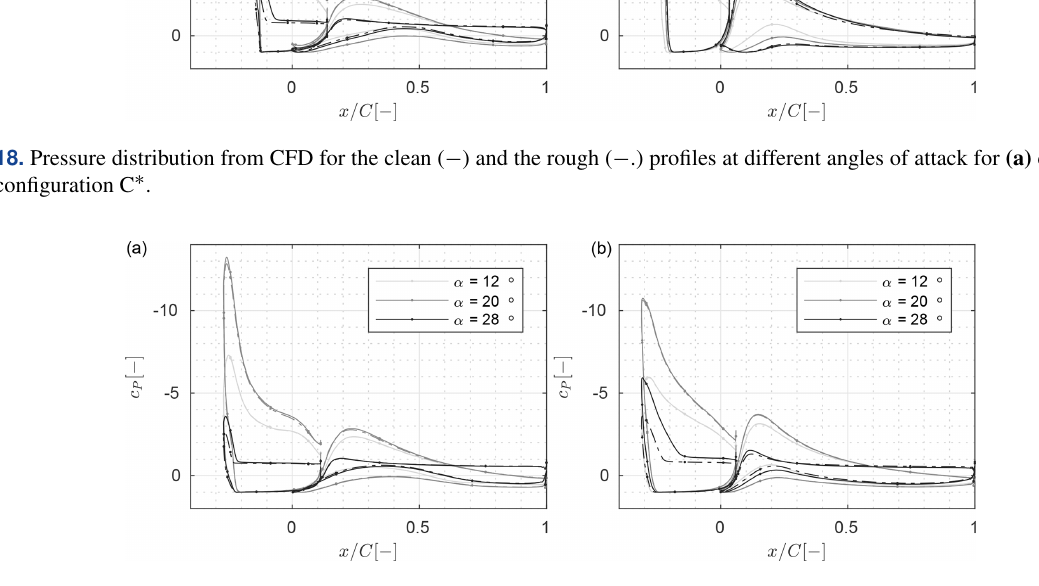
Figure 19. Pressure distribution from CFD for the clean ( − ) and the rough ( − . ) profiles at different angles of attack for (a) configuration D and (b) configuration D ∗